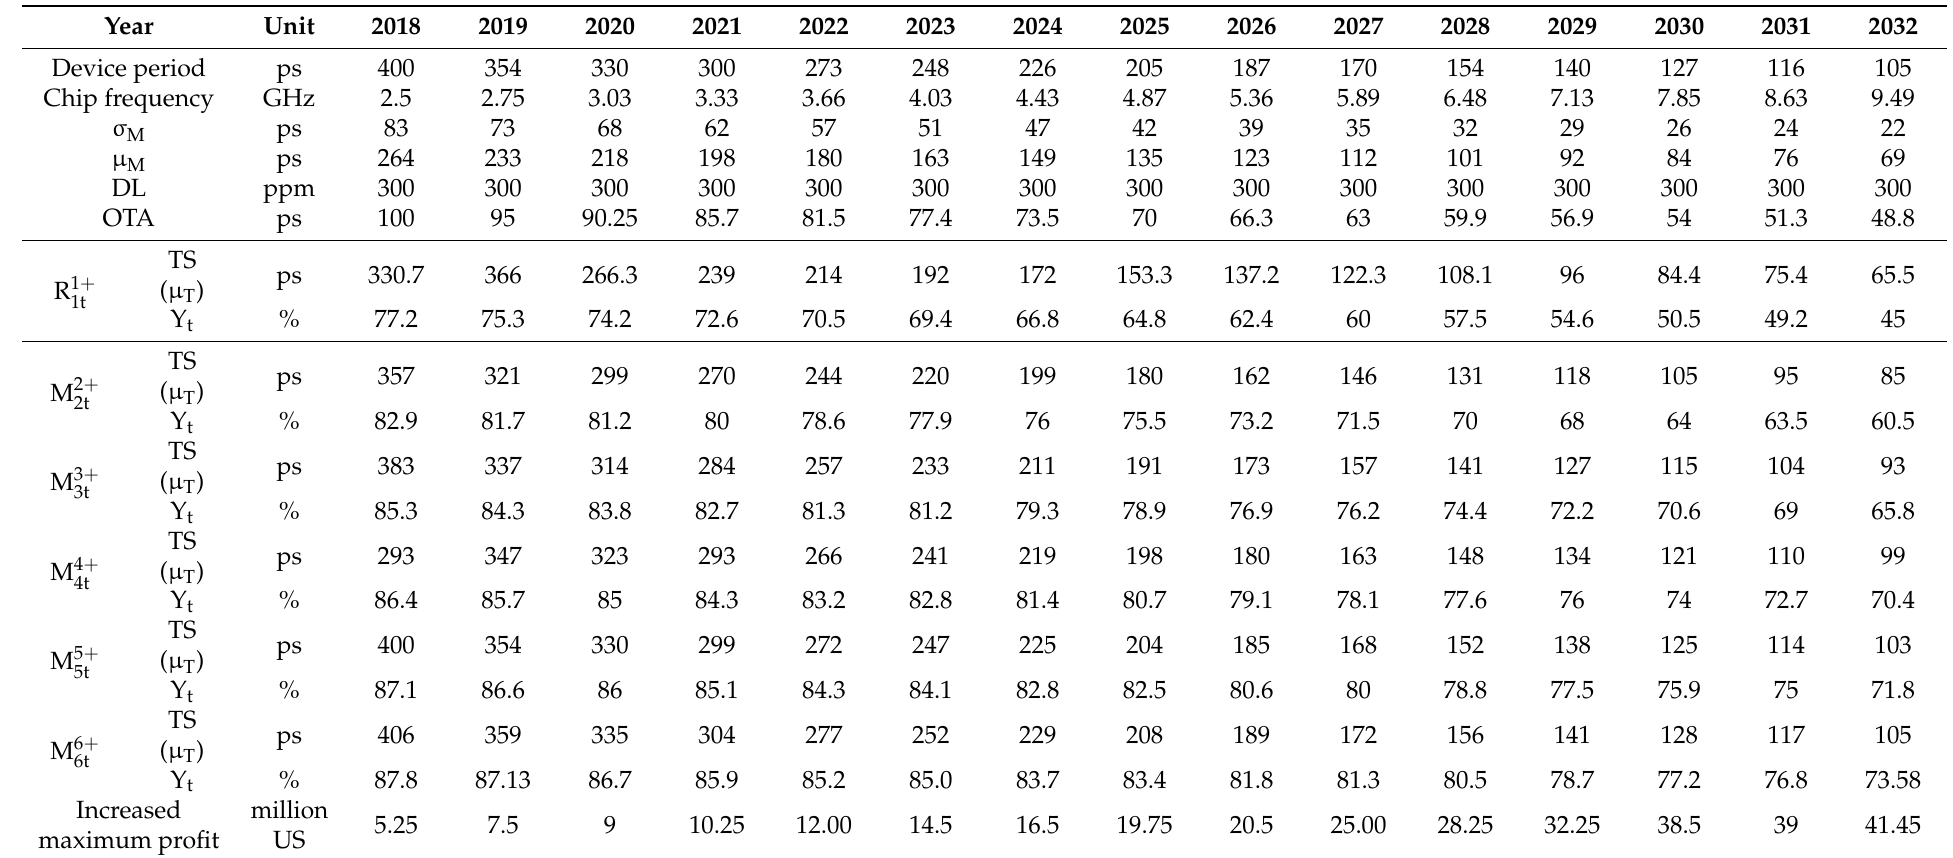
Table 5. Company profit surplus based on the number of